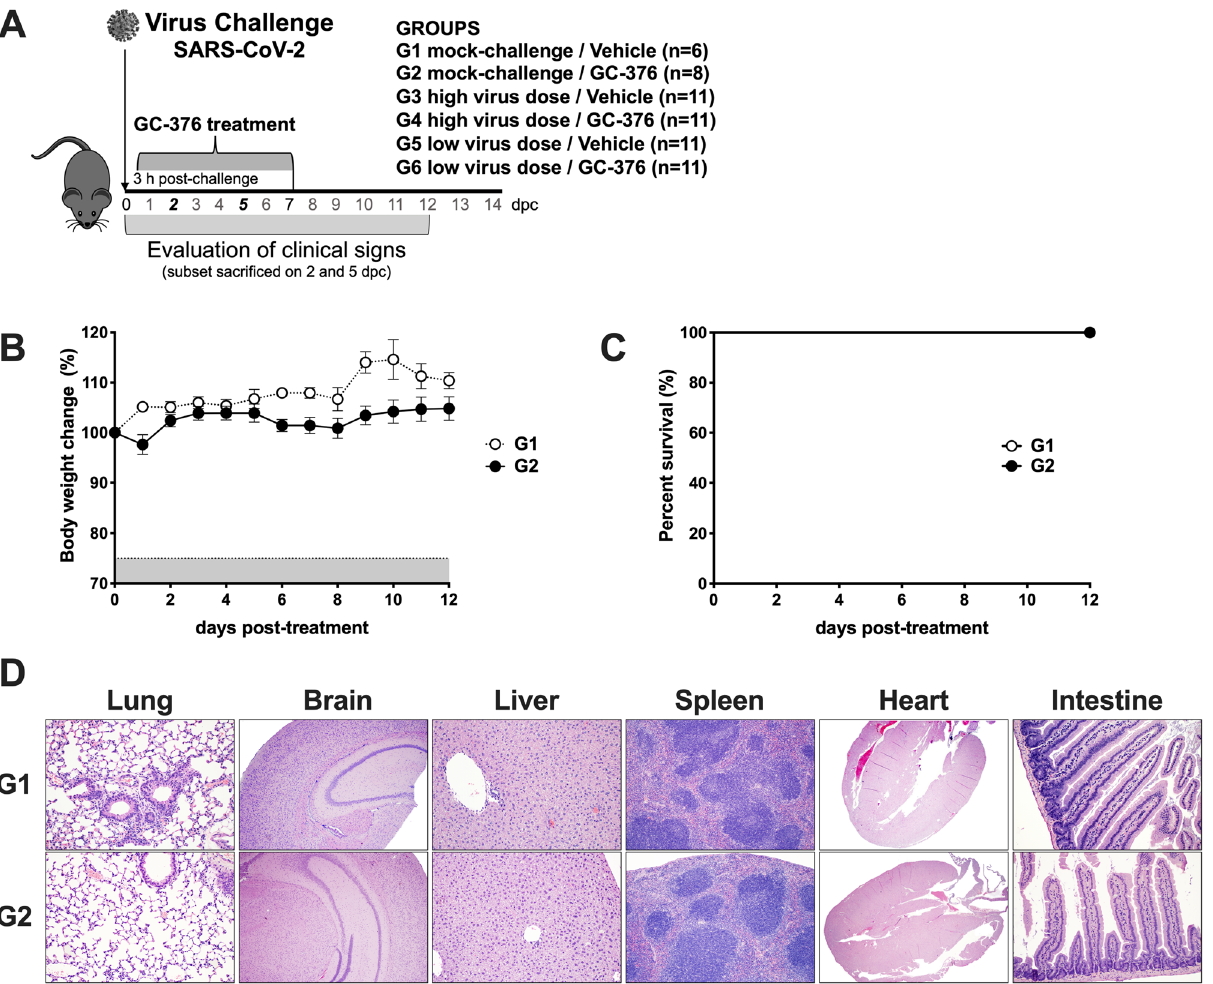
Figure 1. Schematic representation of the experimental design and evaluation of the safety of GC-376 in K18shACE2 mice. ( A ) K18-hACE2 were either mock challenged (G1 and G2) or challenged with SARS-CoV-2 at either a high virus dose (1 × 10 5 TCID50/mouse; G3 and G4) or a low virus dose (1 × 10 3 TCID50/mouse; G5 and G6). I.P. treatment with vehicle (G1, G3, and G5) or GC-376 (G2, G4, and G6, 40 mg/kg day). Subsets of mice were humanely euthanized at 2 and 5 dpc and different tissues were collected. Mice (n = 8) received 40 mg/ kg of GC-376 split in two doses per day for 7 days and ( B ) weight changes and ( C ) survival were monitored for 12 days. ( D ) Mice were humanely euthanized at 14 dpc and lungs, brain, liver, spleen, heart and SI were collected. HE slides were generated and analyzed in comparison with the negative control group. Representative pictures were taken at 20 × magnification for all tissues except brain samples that were taken at 4 ×. SARS-CoV-2 illustration was obtained from the CDC image library (free of any copyright restrictions image ID#23312 by Eckert and Higgins, https:// phil. cdc. gov/ Detai ls. aspx? pid= 23312). Mouse clipart was obtained from the Clipart Library, , with